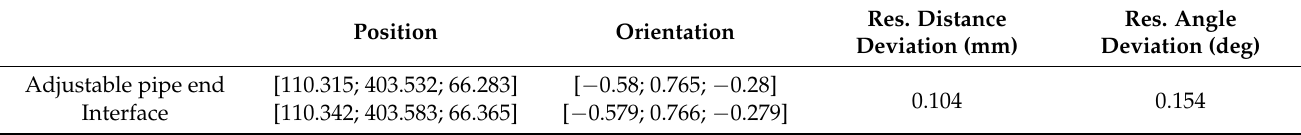
Figure 13. Final assembly by means three adjustment approaches. Table 3. Actual poses of adjustable pipe end and corresponding